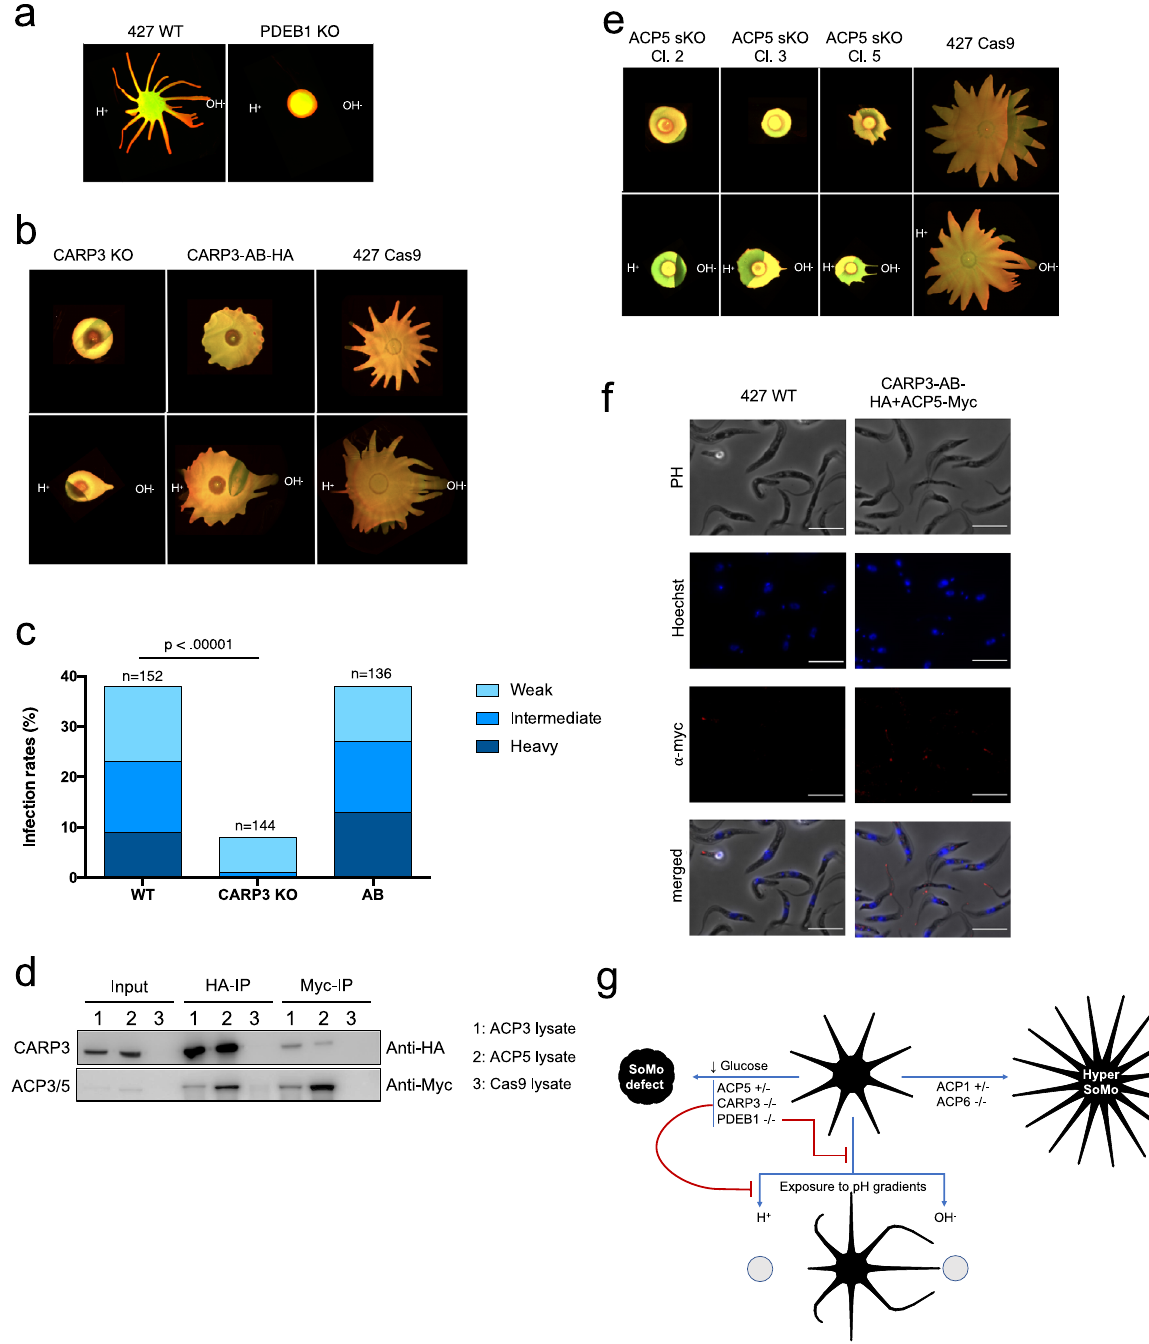
Fig. 6 CARP3 is required for acid sensing in vitro and for establishment of infection in fl ies. a Merged EP and GPEET signals of Lister 427 wt and PDEB1 knockout (KO). b Merged EP and GPEET signals of 427 Cas9 parental line, CARP3 knockout and CARP3-HA addback. Upper panel: untreated. Lower panel: exposed to acid and alkali. c Teneral fl ies were infected with wild-type Lister 427 procyclic forms (WT), the CARP3 double knockout (CARP3-KO) and the addback (AB). Dissections were performed 13 – 14 days post infection. Total numbers are derived from two replicates per cell line (Supplementary Table 2). The intensity of midgut infections was scored as heavy, intermediate or weak as described 36 . The p-value is shown for Fisher ’ s exact test, two-sided ( p - value = 2.0117 − 10 ). d Western blot analysis of immunoprecipitations with anti-HA and anti-myc antibodies (representative blot from three independent experiments). Myc-tagged ACP3 and ACP5 were expressed independently in the CARP3-HA background. The parental line 427 Cas9 was used as a control. Input samples have 40 times fewer cell equivalents than the immunoprecipitated samples. IP: immunoprecipitation with anti-HA or anti-myc antibodies. e Merged EP and GPEET signals of the 427 Cas9 parental line and 3 independent ACP5 single allele knockouts; panels as in ( b ). f Myc-tagged ACP5 is localised to the fl agellar tip in a cell line co-expressing CARP3-HA. Immuno fl uorescence was performed with an anti-myc antibody (red). DNA was stained with Hoechst dye. Scale bar = 10 µ m. g Summary of mutants, SoMo phenotypes and responses to pH. − / − : double knockouts; + / − : single knockouts. Source data are provided as a Source Data fi le.